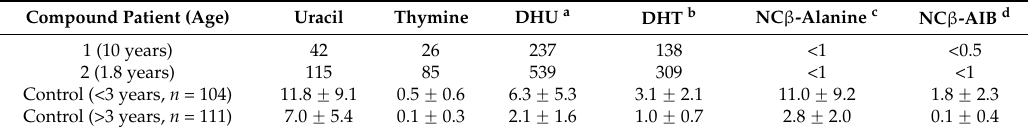
Table 1. Urinary concentrations of pyrimidine metabolites, as determined by